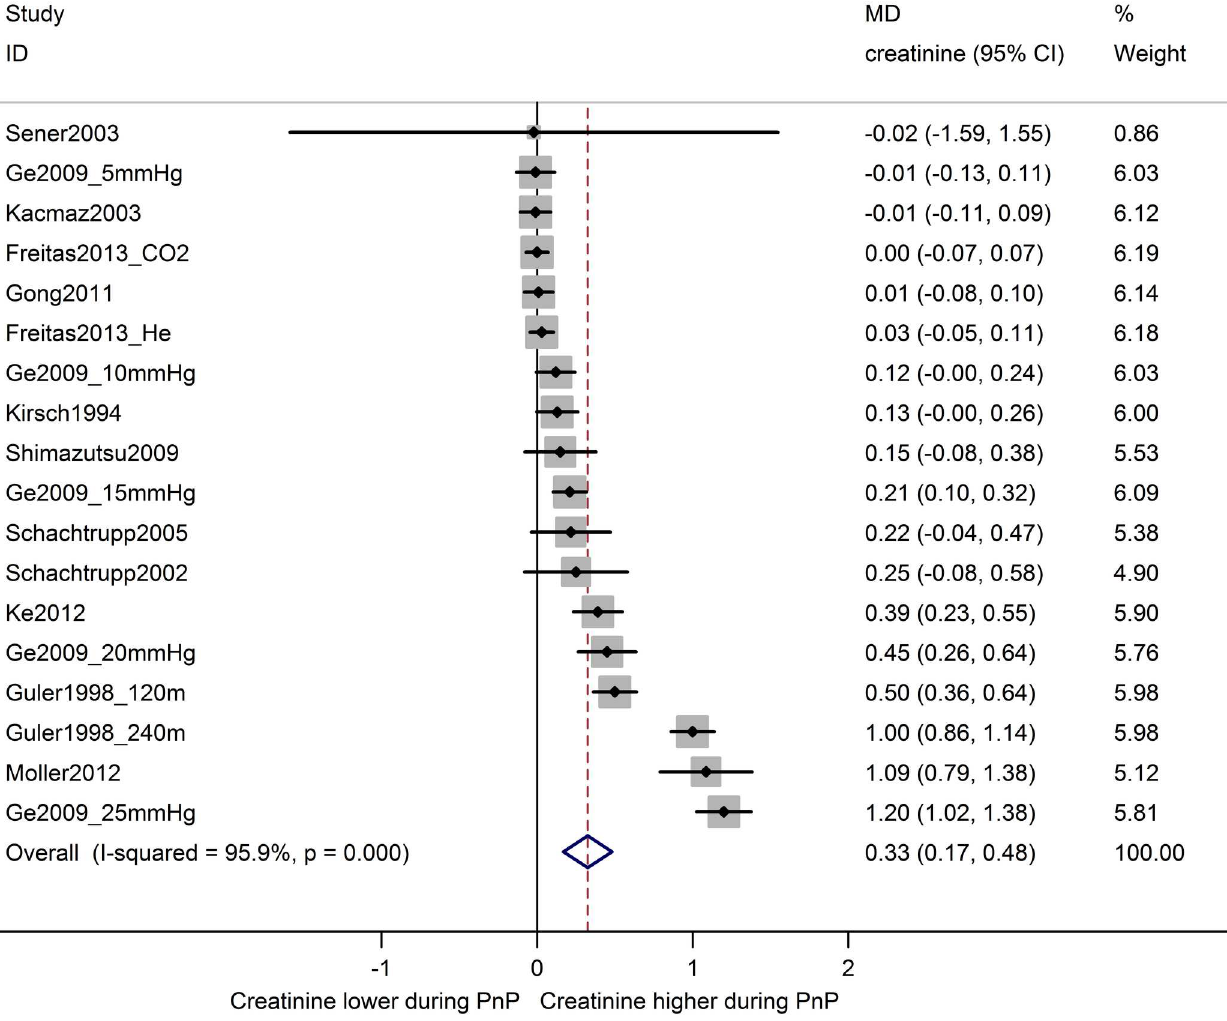
Fig 4. Serum creatinine is increased during pneumoperitoneum compared to controls. Forest plot of studies comparingserum creatininein animals undergoing pneumoperitoneumwith control animals. Effect size is calculated as mean difference (MD) in serum creatininein mg/dl, and corresponding 95% confidenceintervals (95%CI). Weights are from random effects analysis. mmHg = pressure in experimental group; CO2 = insufflation with carbon dioxide; He = insufflation with helium; m = durationin minutes of PnP at time of